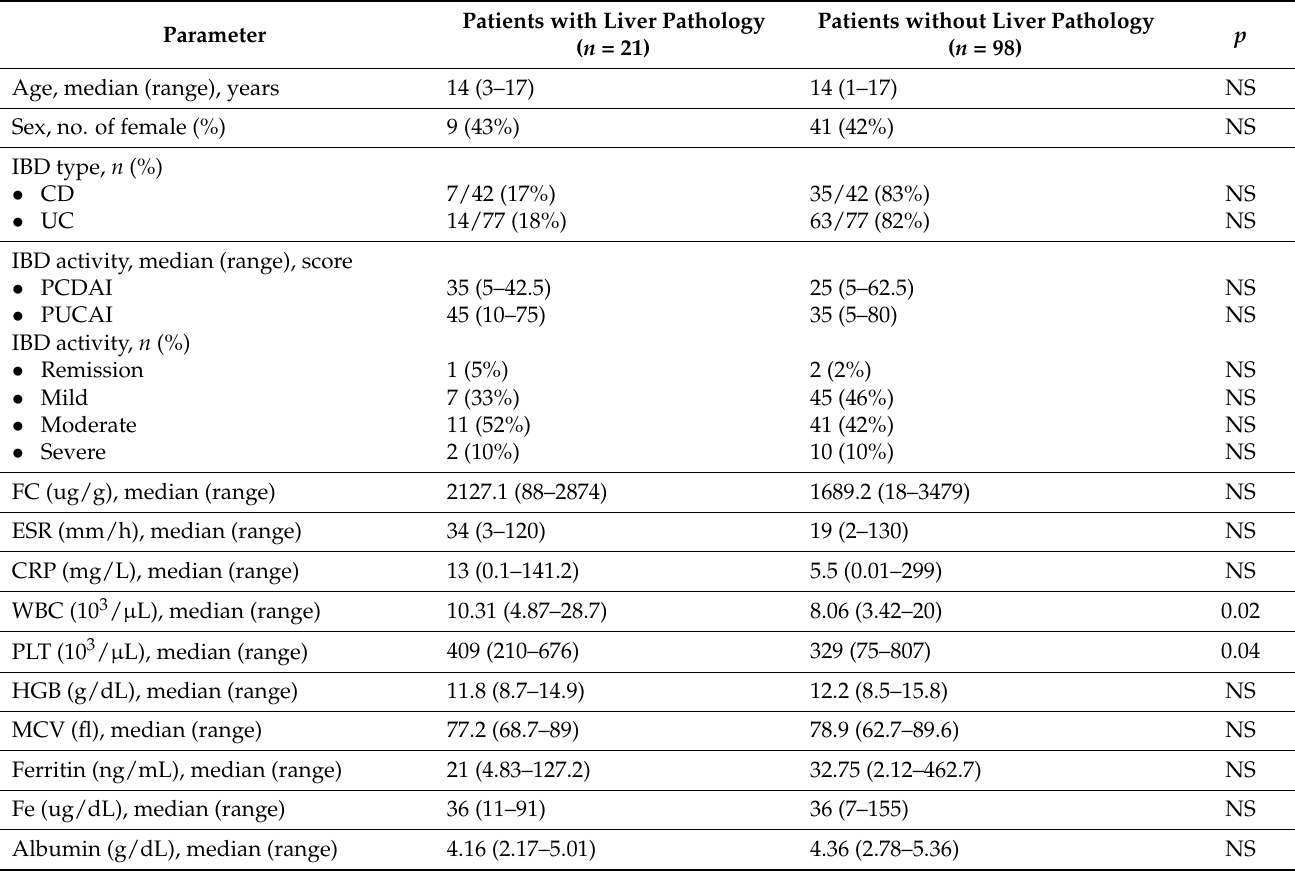
Table 1. Demographic and biochemical parameters of patients with and without liver pathology, collected at the time of the IBD